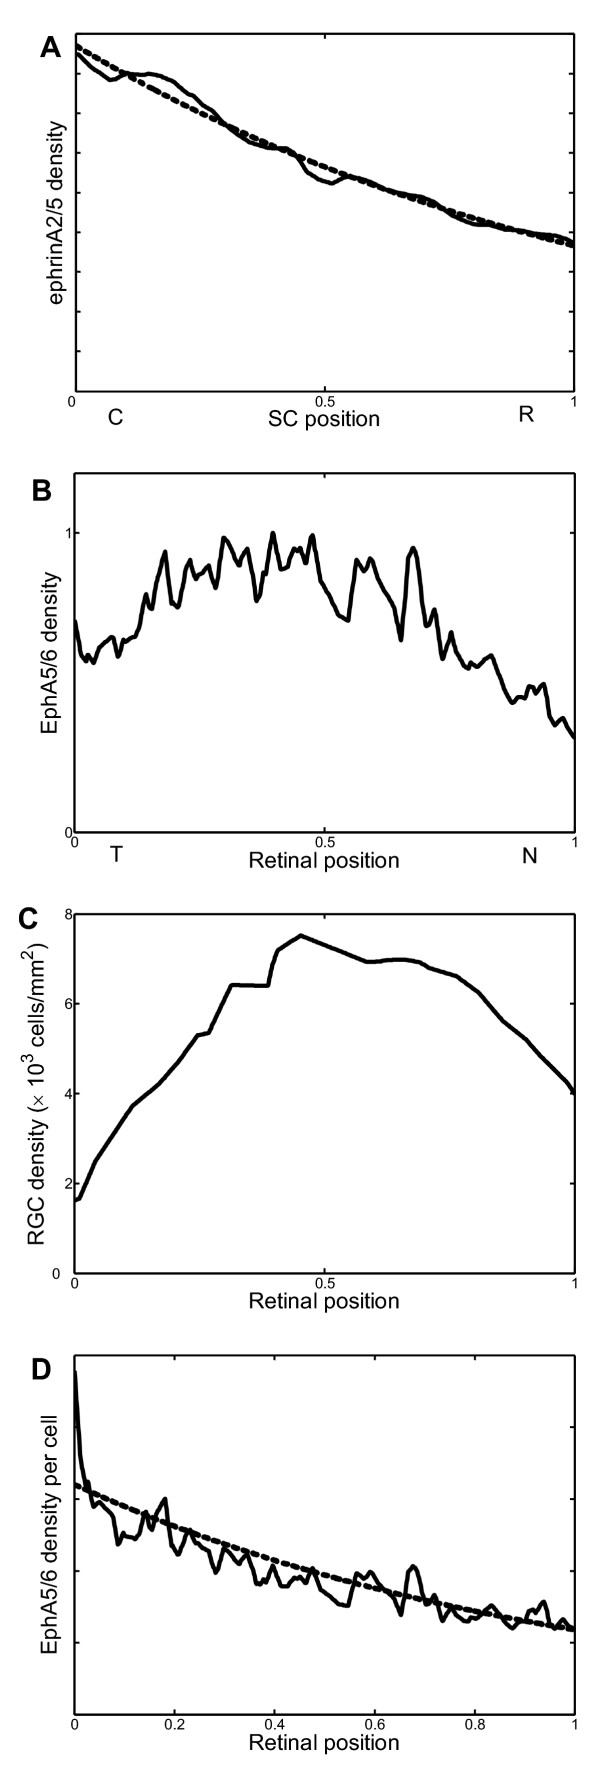
The choice of receptor/ligand expression profiles. A, Density of ephrinA ligands in SC obtained from RNA hybridization [10]. B, Density of EphB receptors in retina from RNA hybridization [20]. C, density of RGC in retina [39]. D, Density of EphA receptor per cell, obtained by dividing B by C. Vertical axes in A, B, and D are in arbitrary units. Dashed lines show the exponential approximations used in this study.